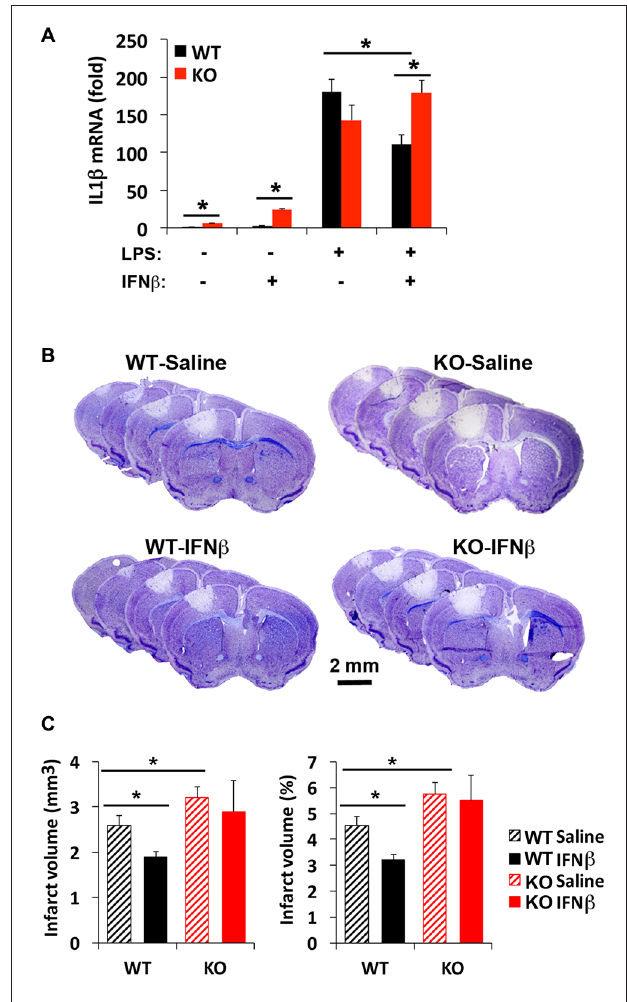
FIGURE 6 | Interferon beta (IFN β ) suppresses inflammatory cytokine activation and reduces stroke injury in WT but not IRF2BP2KO mice. (A) Pre-treatment of WT bone-marrow derived macrophages (BMDMs) with IFN β (100 unit/ml) 2 h prior LPS (10 ng/ml, 4 h) attenuates LPS-induced activation of the inflammatory cytokine IL1 β , and this effect is lost in IRF2BP2KO macrophages. IL1 β mRNA was normalized to GAPDH. N = 4 each. Intravenous delivery of IFN β (10,000 units) 30 min after photothrombosis reduces lesion volume measured at 4 days after stroke (B,C) . This protective effect of IFN β is absent in IRF2BP2 KO mice. N = 10–15 mice/group. ∗ p <